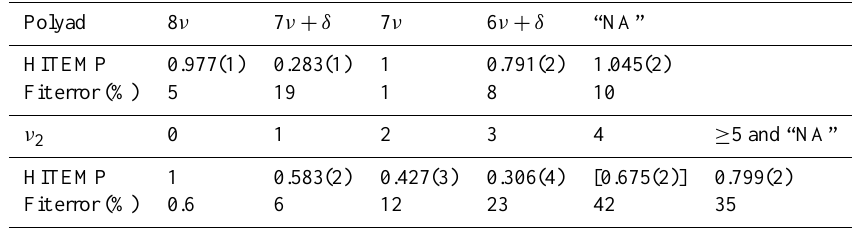
Table 7. Relative absorption strengths as listed in Table 5 for the separated H 2 O absorption cross-section according to the respective polyad shown in Fig. 4. Below the same procedure for the HITEMP line list separated by eigenvalues of the bend mode ν 2 . As in Table 6 the fit error is given in percent at a dSCD of 4 × 10 23 moleccm − 2 of the 7 ν and ν = 0 absorptions respectively. As the wavelength ranges are not as well defined as before, no corrections by the results of radiative transfer modelling listed in Table 4 were done.